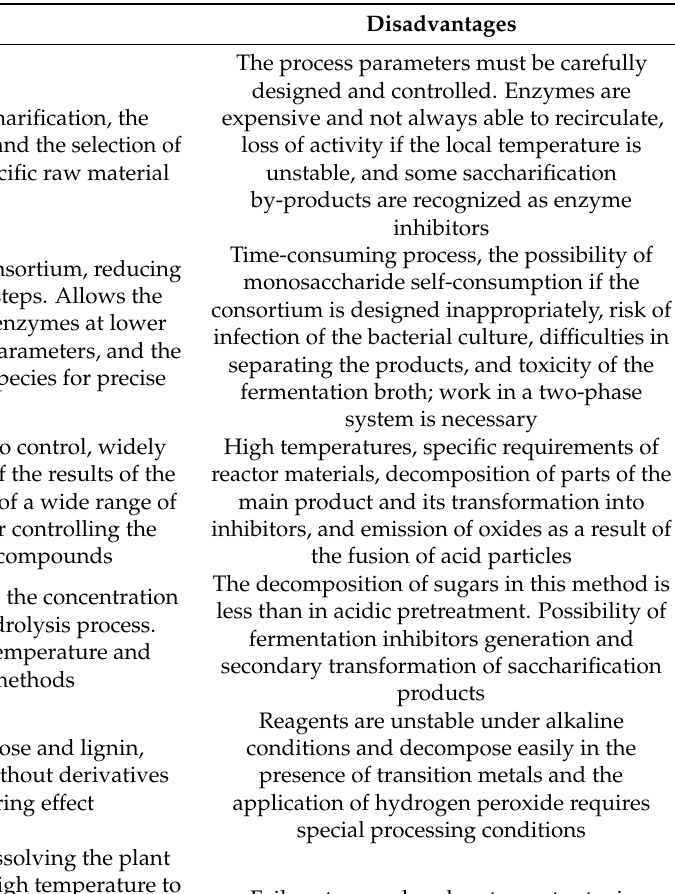
Table 2. Summary of chosen advantages and disadvantages of biomass pre-treatment